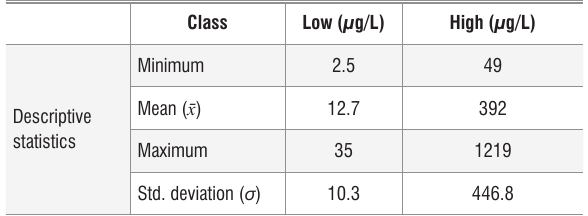
Scatterplot showing the distribution of chl- a samples collected from the Vaal Dam during the 2016 field campaign. Summary of the field data collected in July